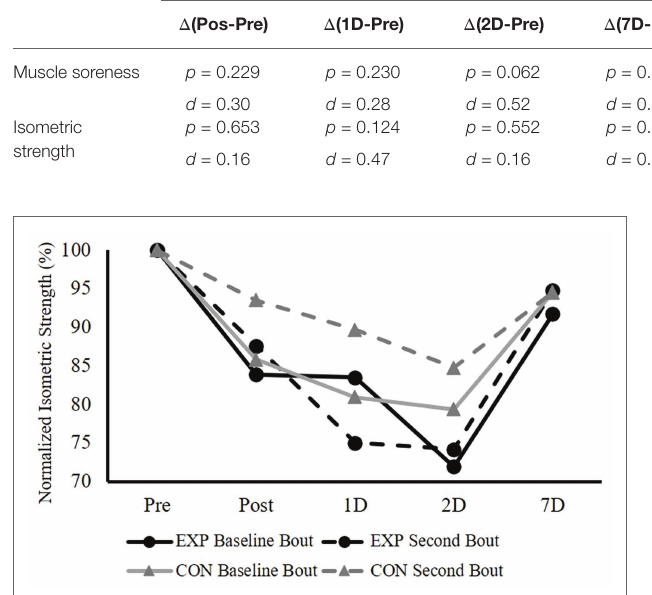
TABLE 2 | The paired comparisons ( p -value and Cohen’s d) of the magnitude of changes from the Pre-testing value in muscle soreness and maximal isometric strength at each time point between the baseline bout and the second bout for both EXP and CON groups. EXP: Baseline bout vs. Second bout